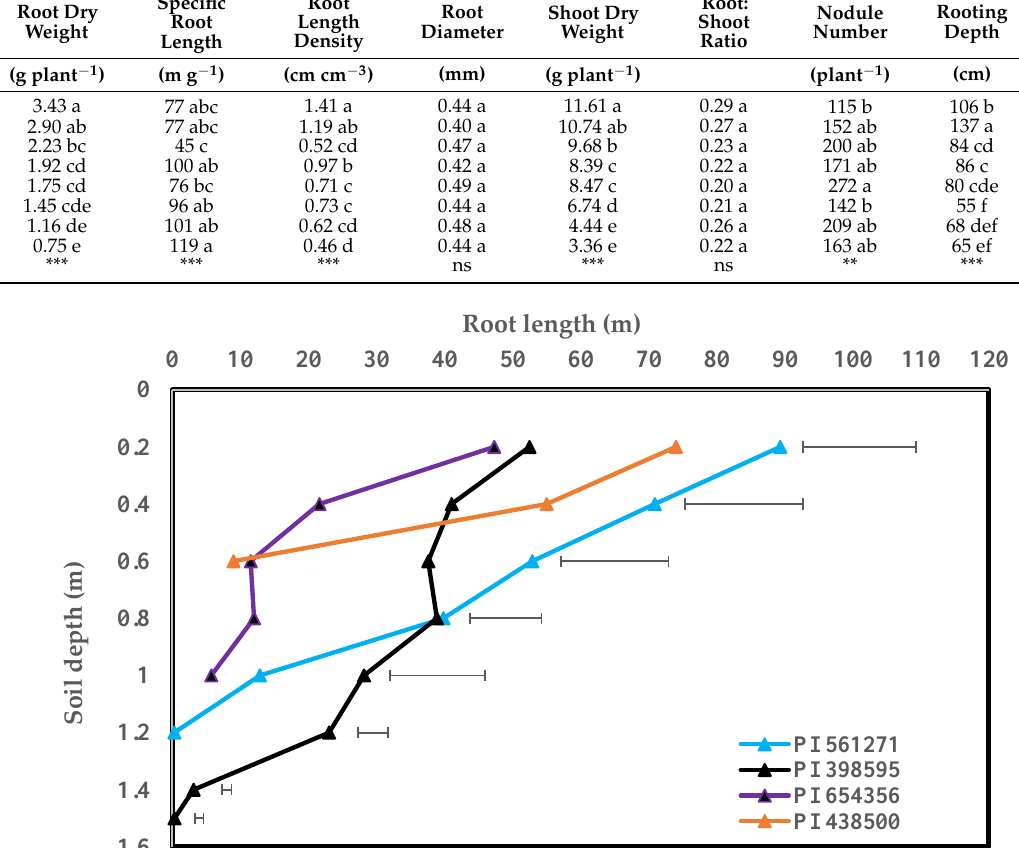
Figure 5. Destructively measured section-wise root lengths in soil profiles (0.2 m sections from top to bottom of each rhizobox) of four soybean genotypes at flowering. Horizontal bars represent least significant difference (LSD) at ( p < 0.05) for genotype comparisons at each section increment in the soil profile.